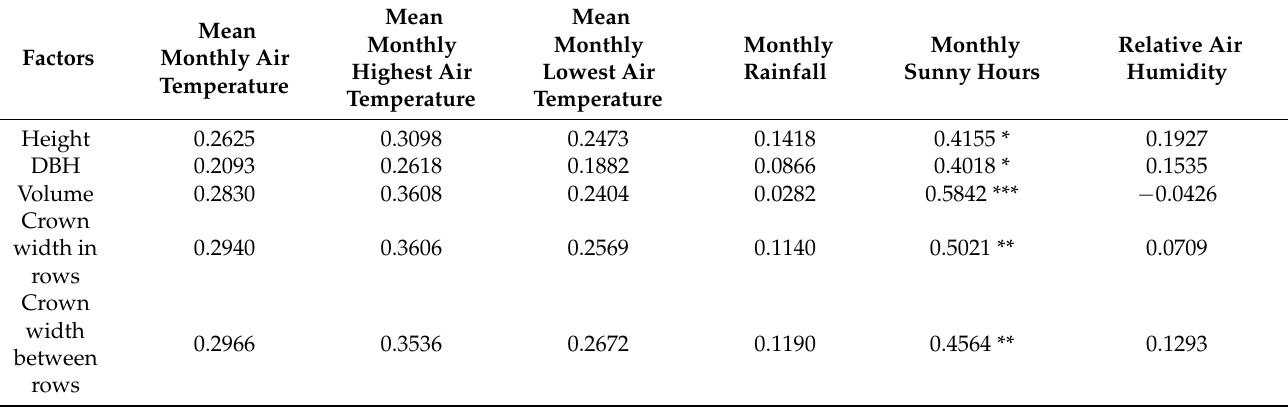
Table 9. The correlation analysis between growth traits of C. axillaris and meteorological factors of the previous month.